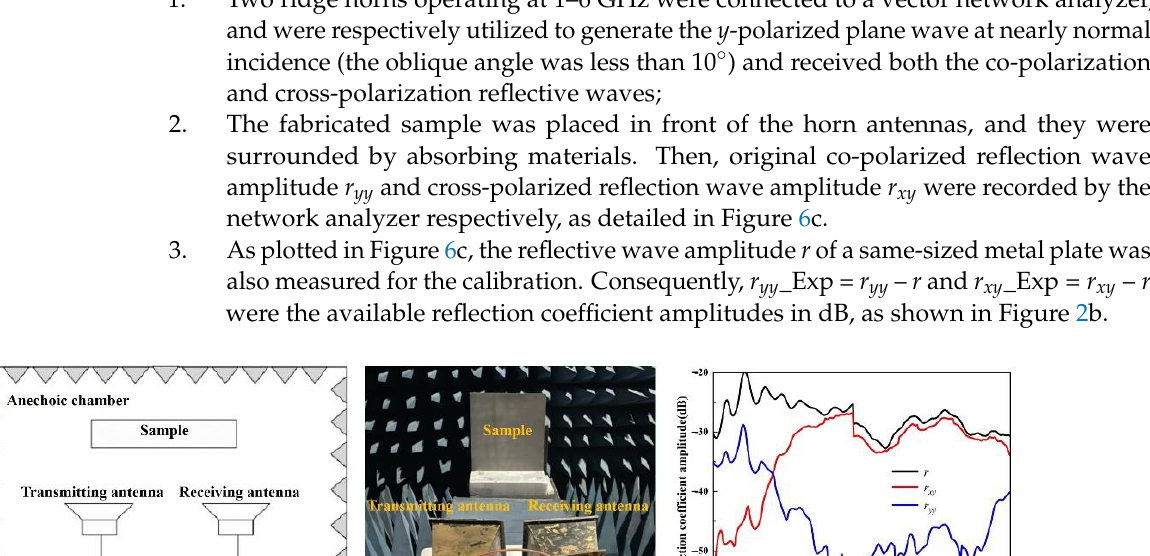
Figure 5. Schematic of incident waves propagating in the MPC described by the reflection, transmission, and emergent wave resulting from the multiple reflections. ( a ) Normal incidence; ( b ) Oblique incidence.